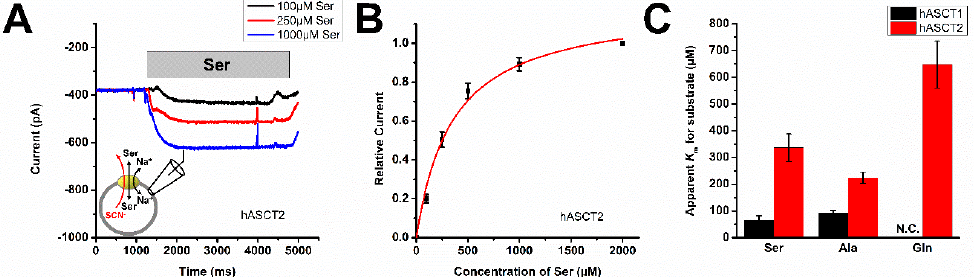
Figure 1. ASCT1 and 2 apparent substrate affinity and selectivity. ( A ) Typical current recording example with ASCT2 at varying serine concentrations (time of application indicated by the grey bar). ( B ) The serine apparent K m was determined as 350 ± 60 μ M for ASCT2 by fit of a Michaelis-Menten-like equation (red line). Relative current was determined by normalizing all current responses to the response obtained at 2 mM serine. ( C ) Comparison of K m values for three substrates of ASCT1 and ASCT2. N.C. indicates no current was observed. Whole cell current recording experiments were performed under homo-exchange conditions: 130 mM NaSCN and 10 mM of serine in the pipette solution, the extracellular solution was 140 mM NaMes and variable concentration of substrate at V = 0 mV.